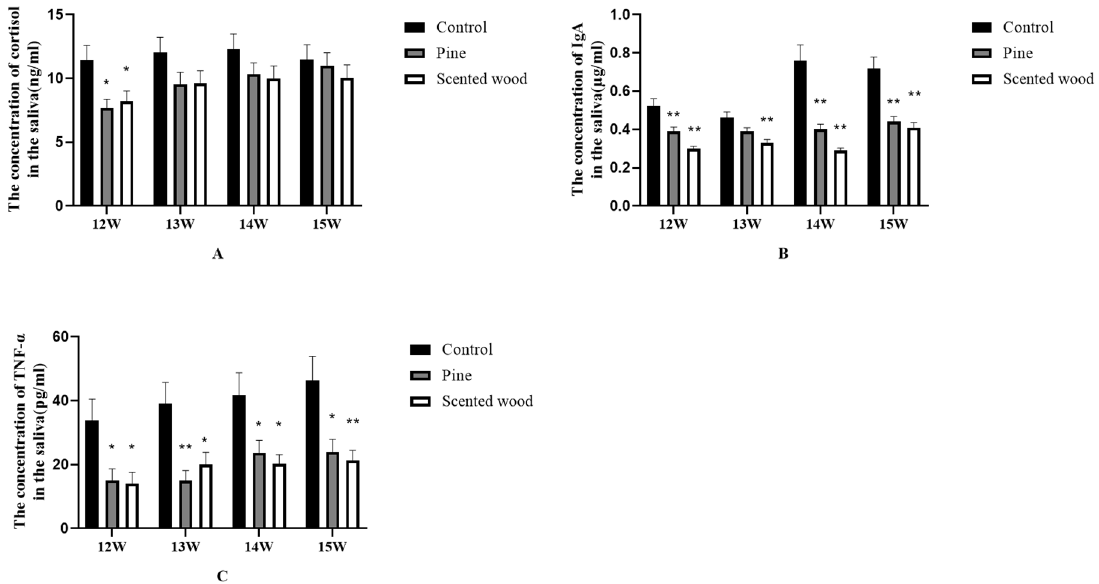
Figure 6. ( A – C ): Effect of enrichment items on the concentration of cortisol, IgA, and TNF- α in the saliva of sows (12 W–15 W). * p < 0.05 and ** p < 0.01 in the enrichment item groups vs. the control group. The data are expressed as mean ± SEM (n = 10).